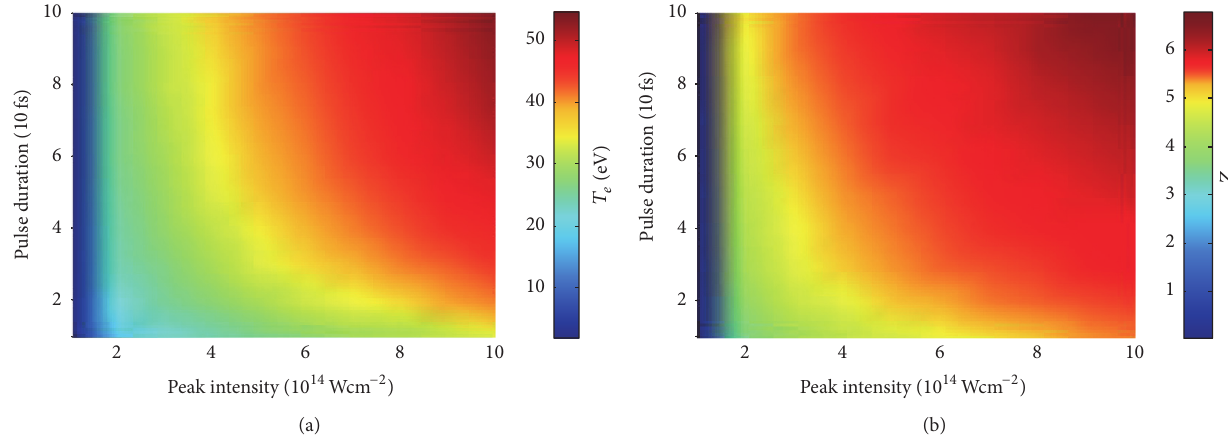
Figure 2: False color map of 𝑇 𝑒 (a) and 𝑍 𝑐 (b) in Ar cluster at 𝑡 = 1.3𝜏 for an 825 nm wavelength pulse versus pump intensity and duration pulse 𝜏 = 40 fs.